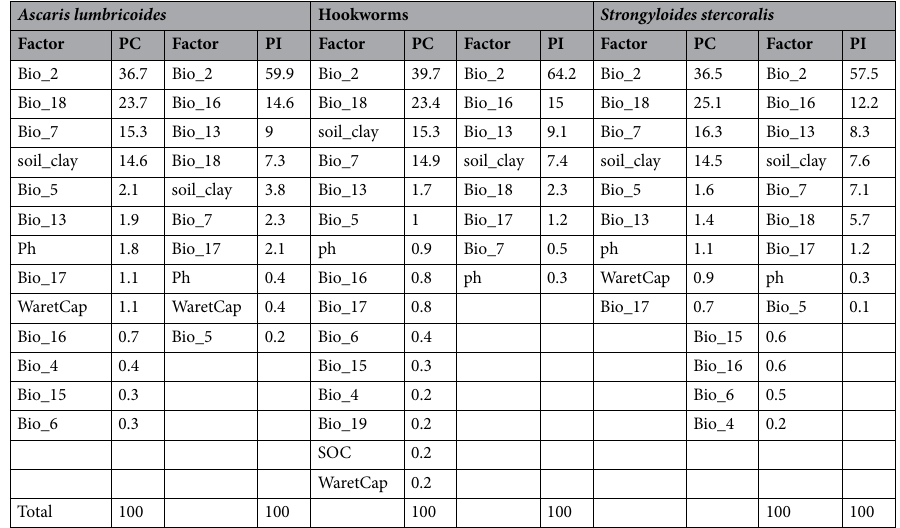
Table 3. Average Percent Contribution and Average Permutation Importance (API) of STHs Infection Distribution Models. PC—Percent Contribution, PI—Permutation Importance. BIO2—Mean Diurnal Range, BIO4—Temperature Seasonality, BIO5—Maximum Temperature of Warmest Month, BIO6—Mini Temperature of the Coldest Month., BIO7—Temperature Annual Range, BIO13—Precipitation of Wettest Month, BIO15—Precipitation Seasonality, BIO16—Precipitation of Wettest Quarter, BIO17—Precipitation of Driest Quarter, BIO18—Precipitation of Warmest Quarter and BIO19—Precipitation of Coldest Quarter, soil_clay—Soil Clay, ph—pH, WaretCap—Water Retention